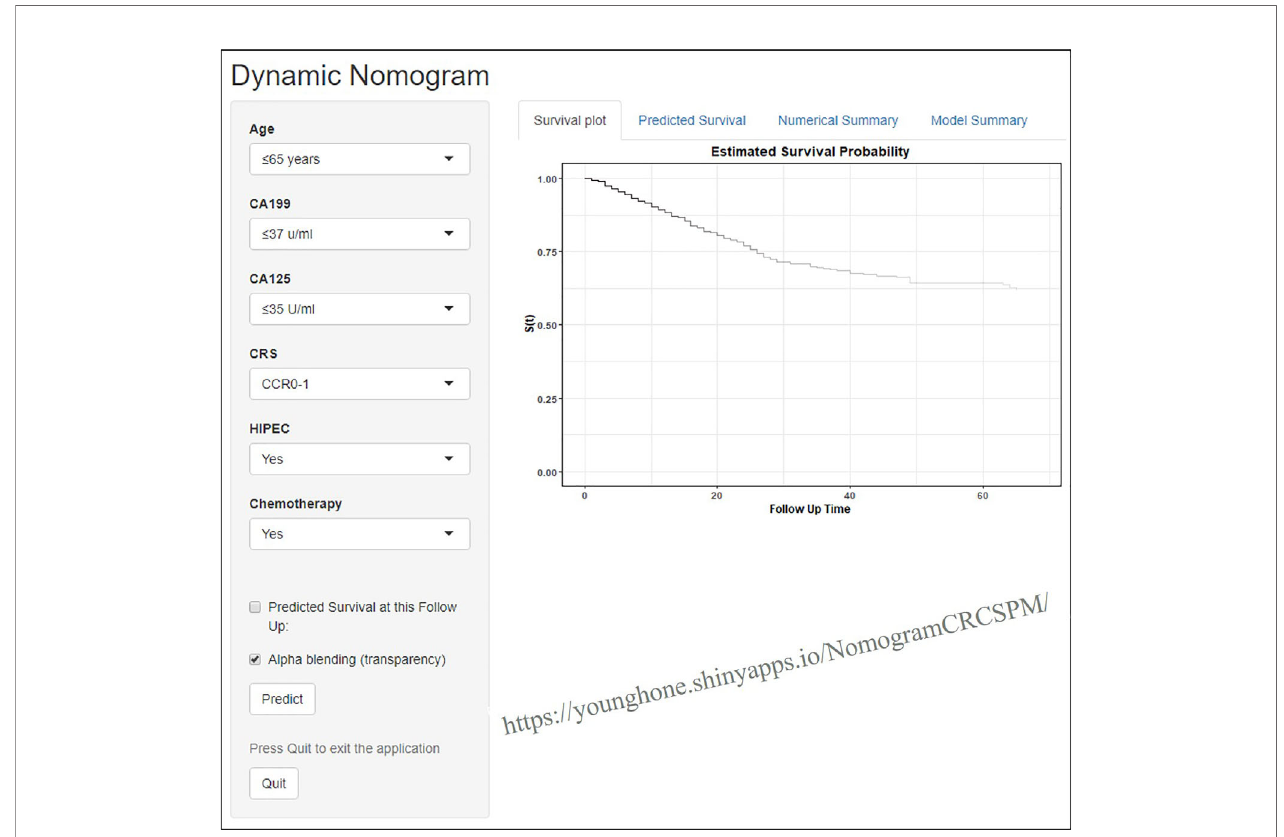
FIGURE 4 | Webserver display of the online dynamic